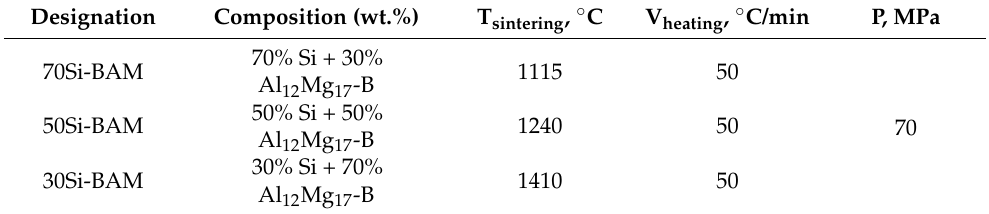
Table 2. Designation of specimens and parameters of spark plasma